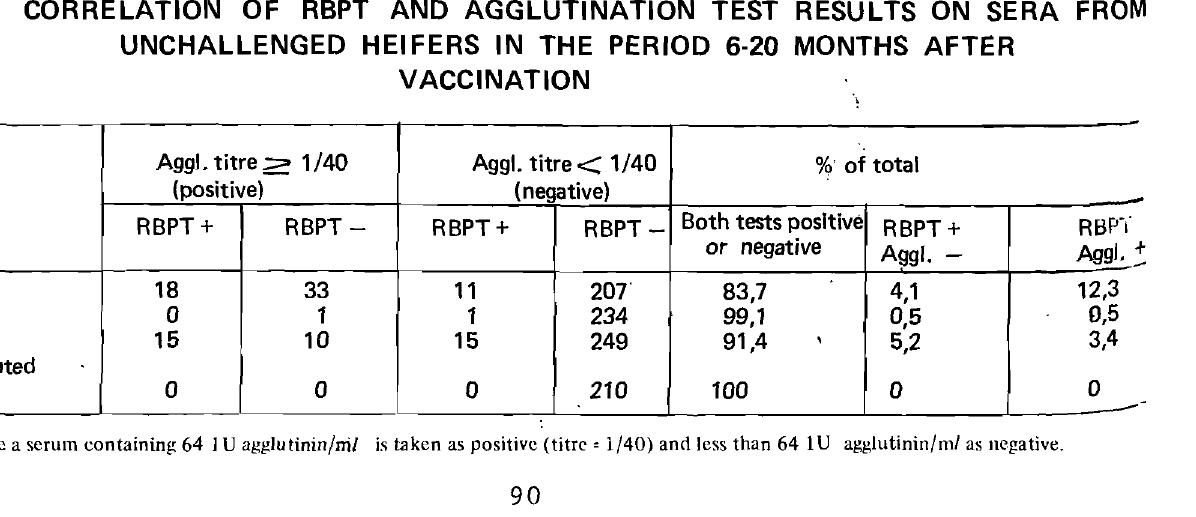
CORRELATION OF RBPT AND AGGLUTINATION TEST RESULTS ON SERA FROM UNCHALLENGED HEIFERS IN THE PERIOD 6-20 MONTHS AFTER